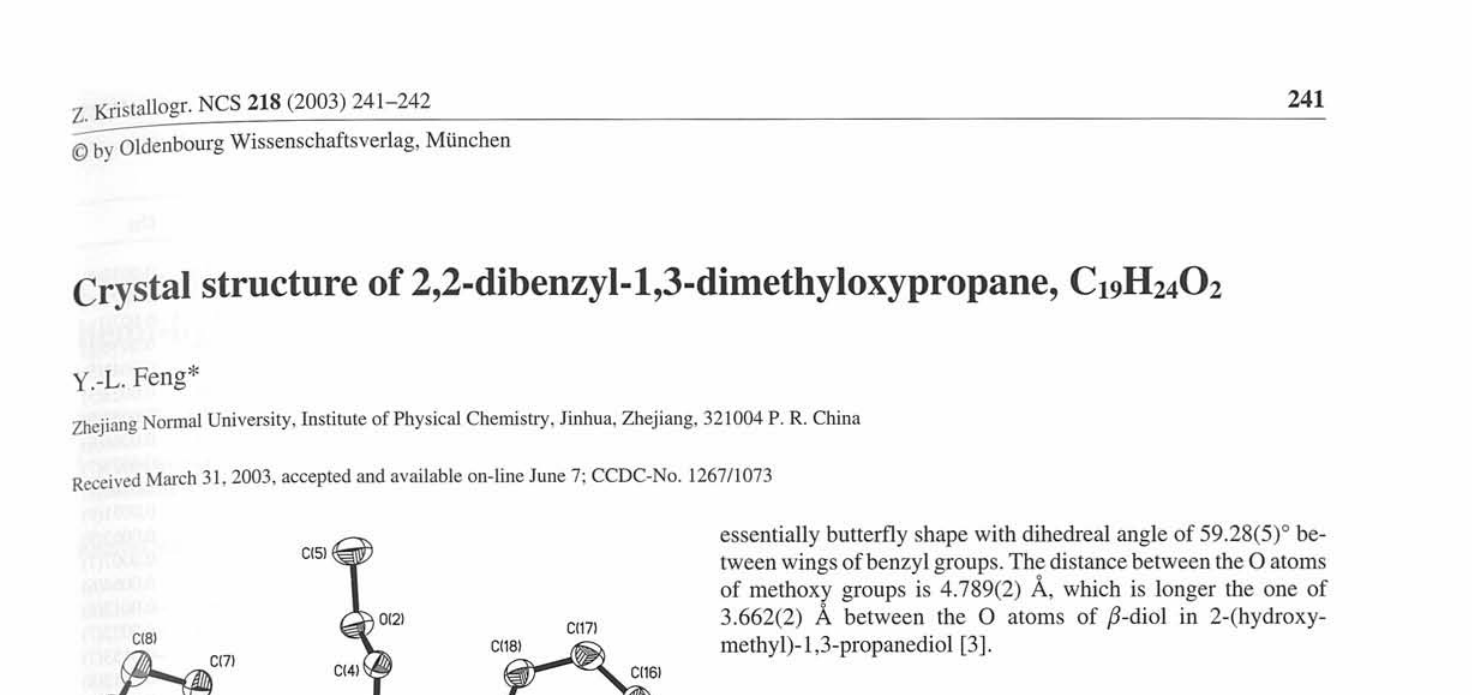
Table 1. Data collection and handling.